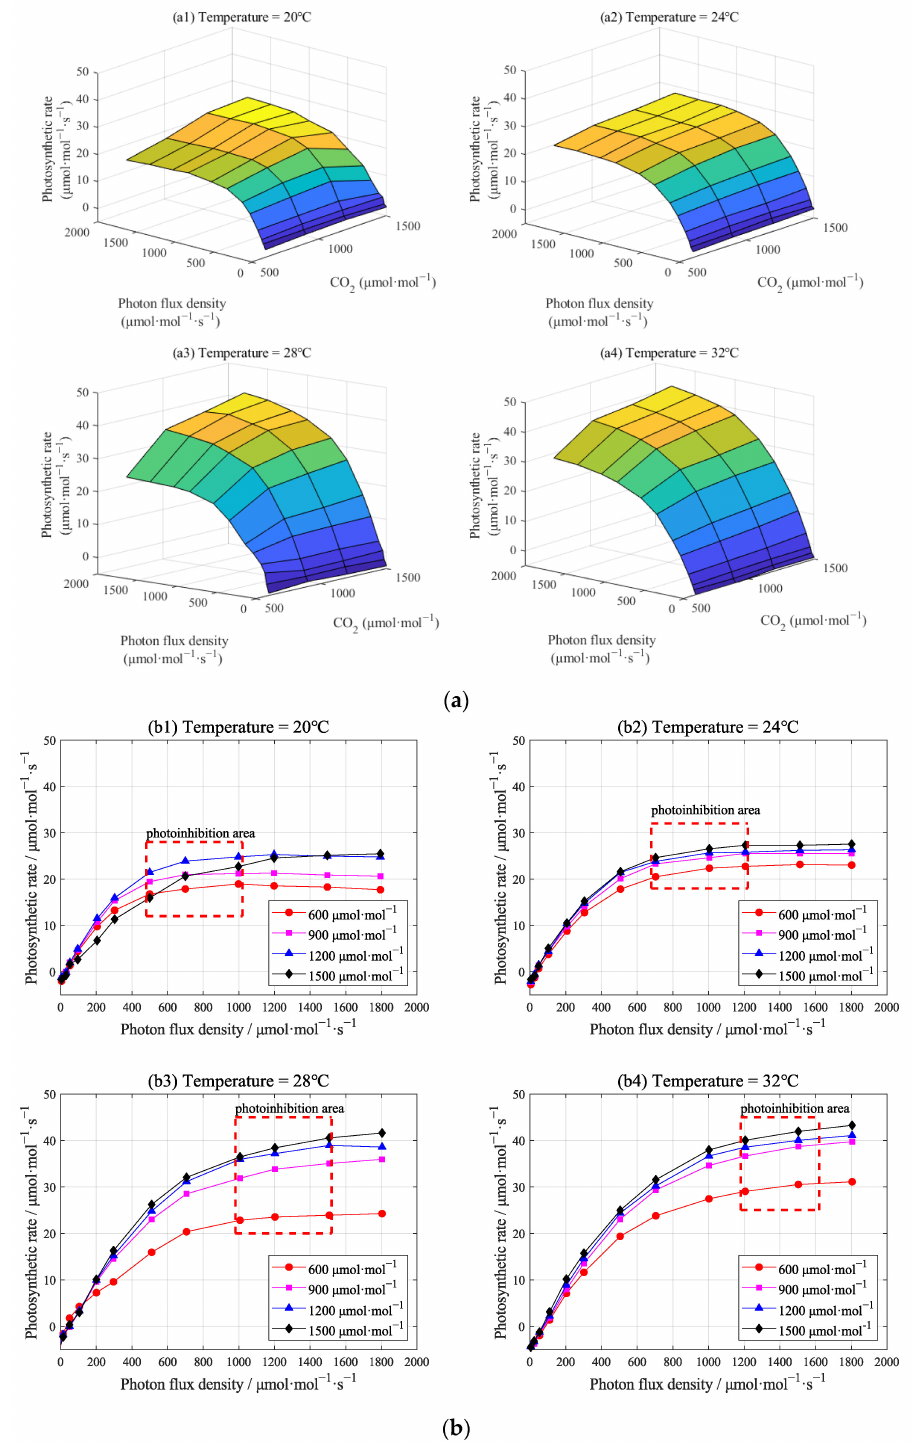
Figure 3. ( a ) . The response surface of photosynthetic rate to photon flux density and CO 2 concentra- tion at different temperatures (changing temperature). ( b ). The light response curve of cucumber photosynthetic rate under different environmental conditions (changing CO 2 concentration and temperature). The photoinhibition points of the light response curve are marked with red boxes in the subfigures of Figure